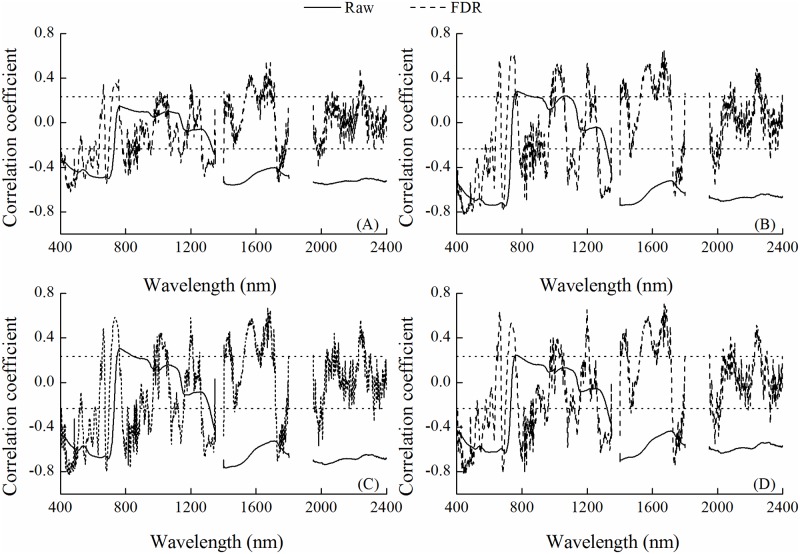
Correlation between water metrics and raw reflectance and between water metrics and the first derivative reflectance in winter wheat (n = 120).(A) equivalent water thickness (EWT), (B) canopy water content (CWC), (C) leaf water content (LWC) and (D) plant water content (PWC). The horizontal dotted lines represent the correlation coefficient threshold values at the 0.01 probability level.